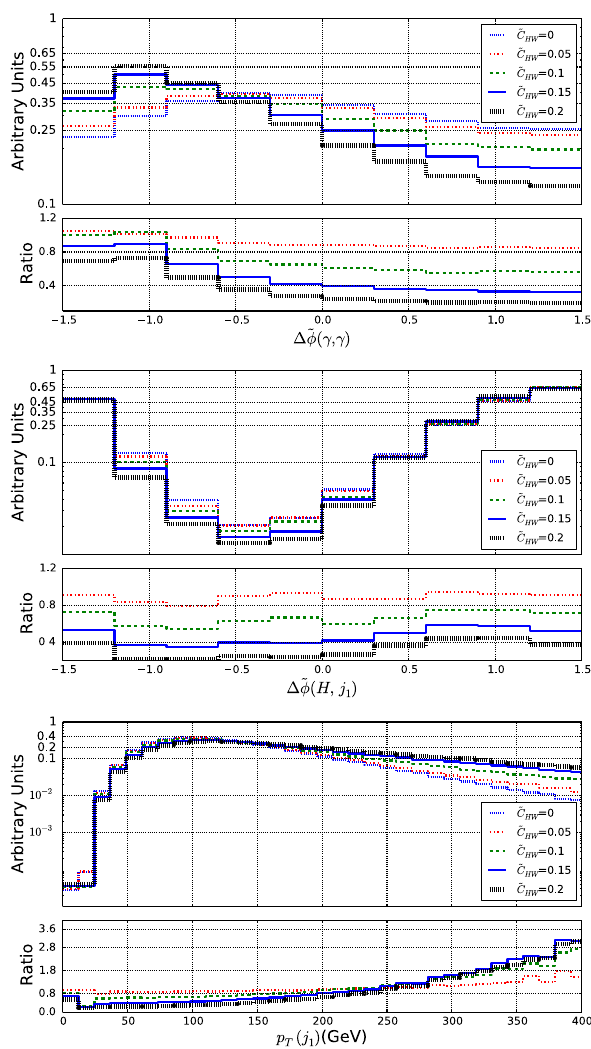
Fig. 9 Representative kinematical properties of the decay product of a Higgs boson produced by vector-boson fusion and that decays into a photonpairwhenproducedinLHCcollisionsatacenter-of-massenergy of 13 TeV. We consider the angular separation in azimuth between the photon pair originating from the Higgs-boson decay (top), the angular separation in azimuth between the reconstructed Higgs boson and the leading jet (center) and the transverse momentum of the leading jet (bottom). We allow for different values for the ˜ c HW parameter and we present, in the lower panels, the bin-by-bin ratio of the new physics predictions to the Standard Model